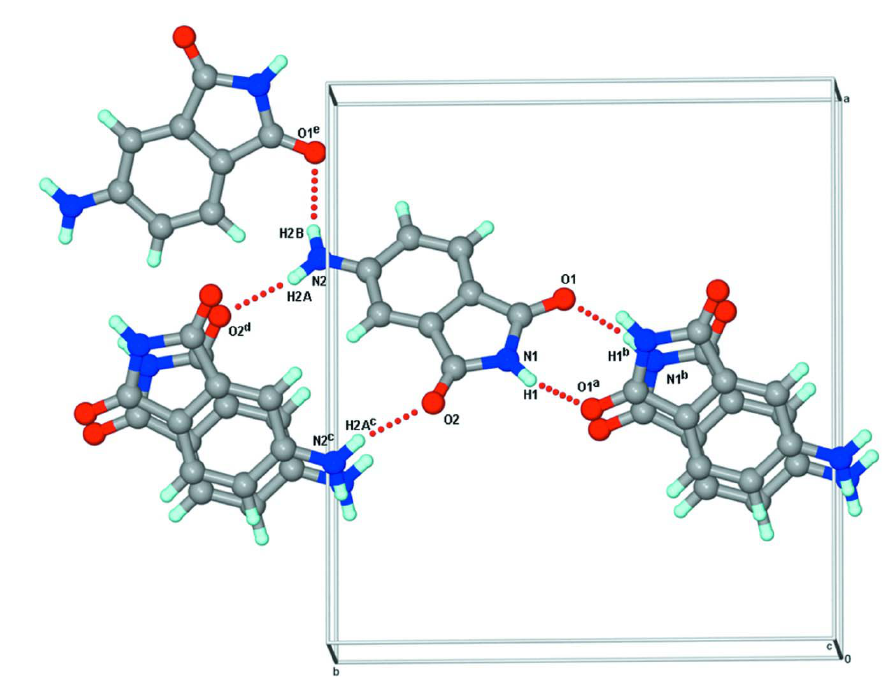
Figure 2 Molecular chain along the c axis.